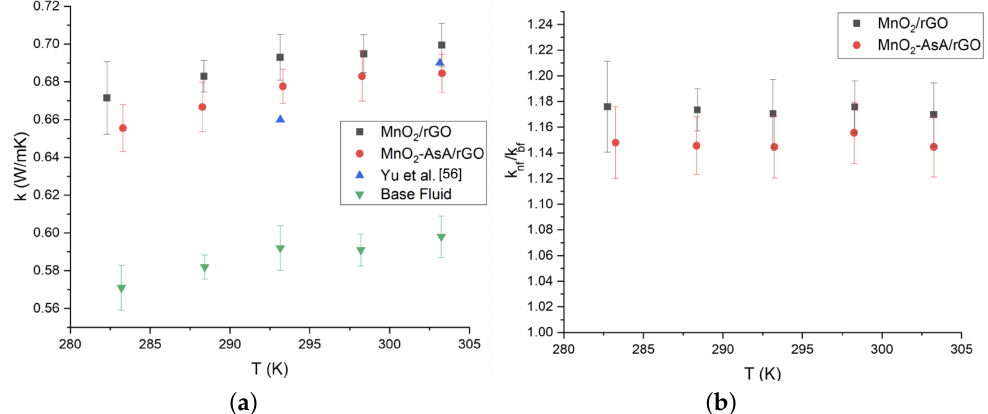
Figure 11. ( a ) Thermal conductivity of the nanofluids based on MnO 2 /rGO composites versus temperature and ( b ) relative thermal conductivity of nanofluids synthesized with of the nanofluids based on MnO 2 /rGO composites respect to the base fluid. The error bars ( a ) correspond to the measurements’ standard deviation and the propagation error ( b ) according to Equation